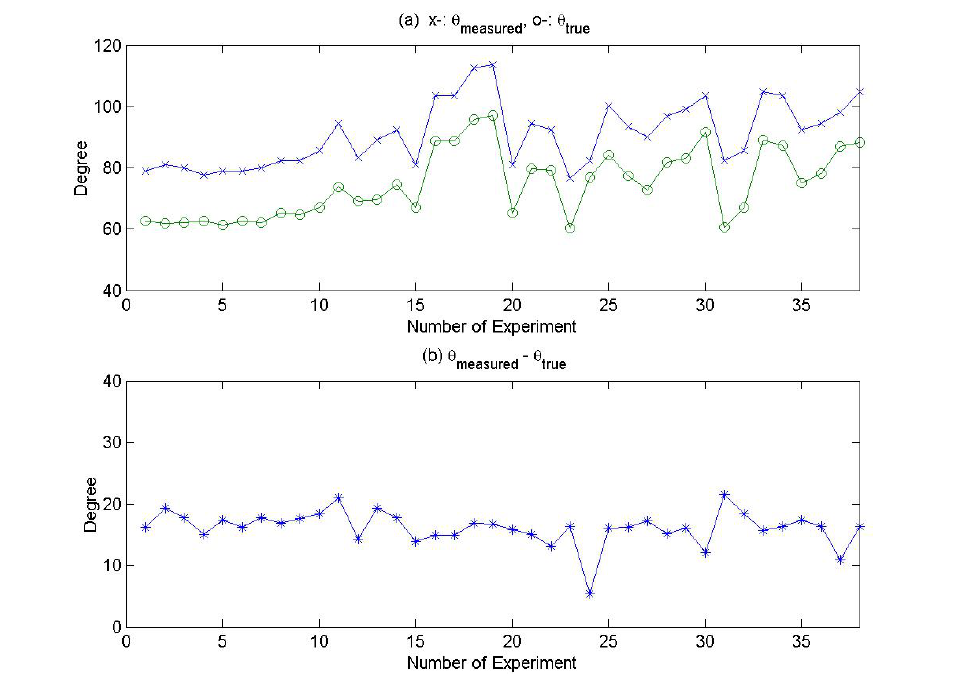
θ and true measured